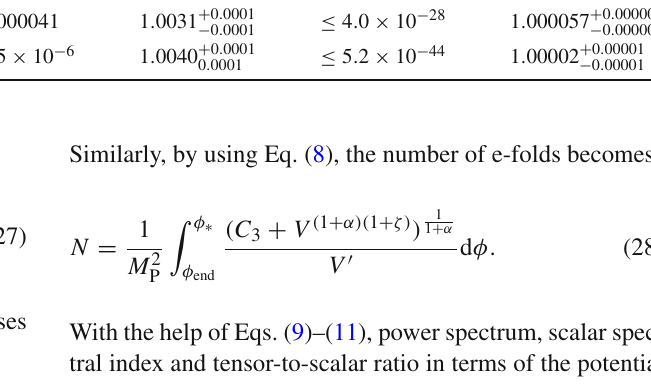
Fig. 6 Plot of r versus n s for GCG model in weak (left panel) and strong (right panel) dissipative regimes for negative potential with n = − 2 Table 3 GCG Weak and strong Sr. dissipative regime with negative quadratic and quartic potential